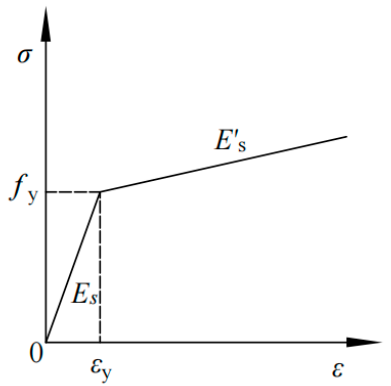
Figure 1. Constitutive analysis of steel bars.